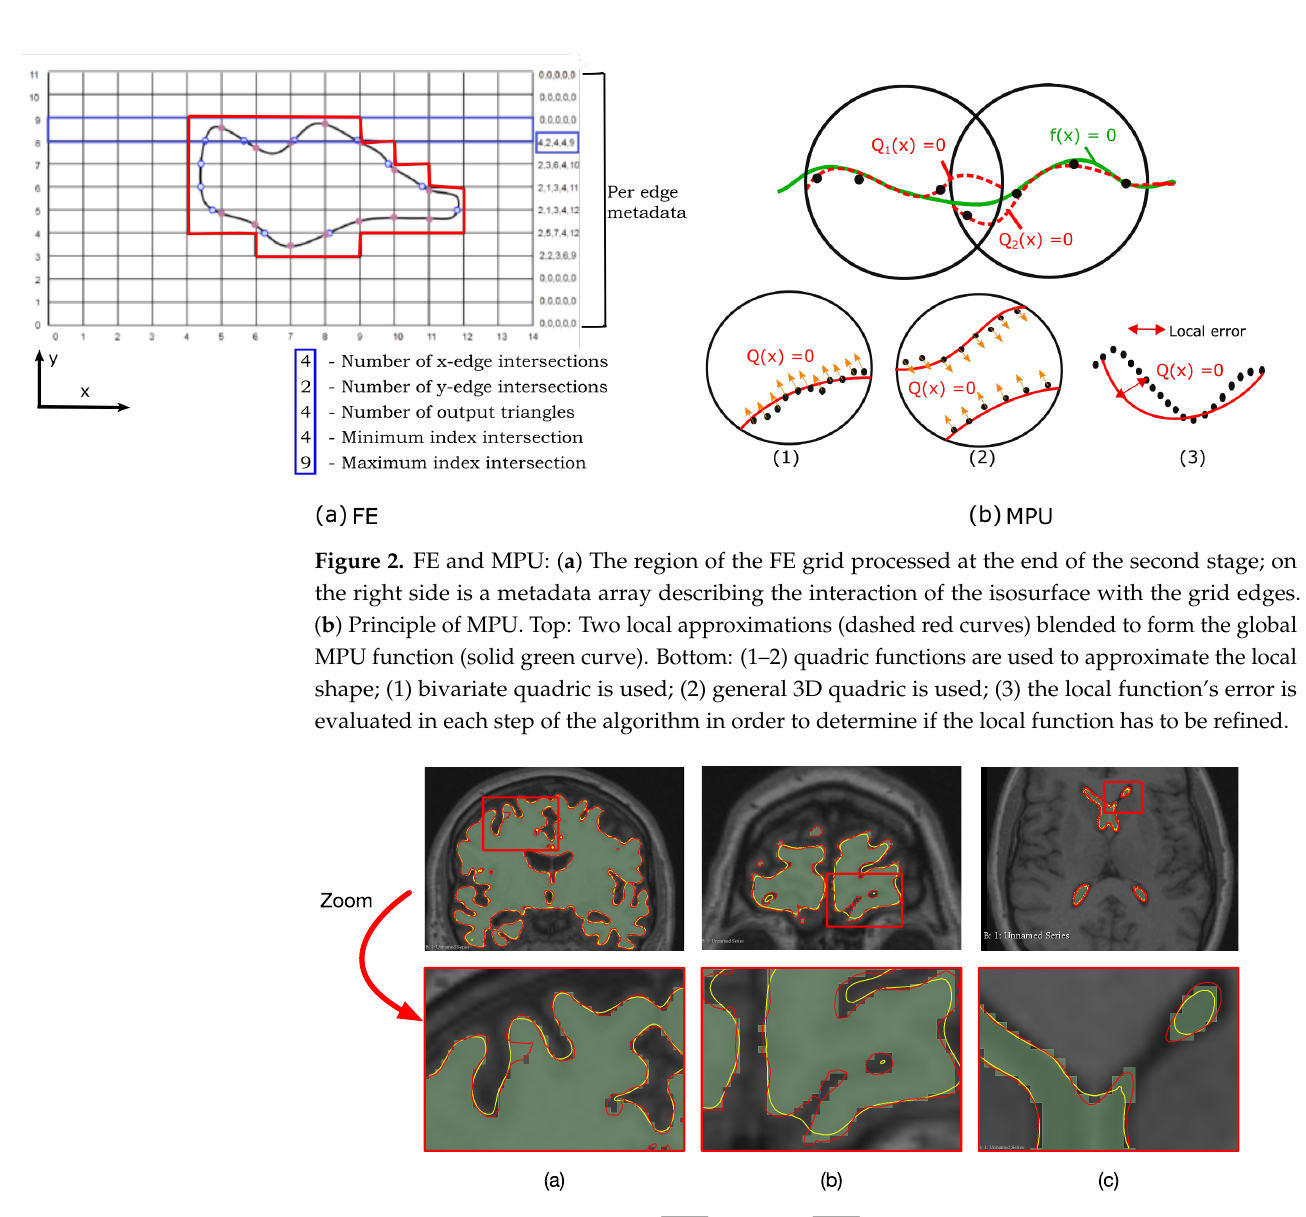
Figure 3. Reconstruction of the brain and ventricle with FE (in yellow) and MPU (in red); ( a , b ) coronal brain cross-sections; ( c ) axial ventricle cross-section; (top) overlaid models; (bottom) a zoom on the red rectangle showing the reconstruction results of each